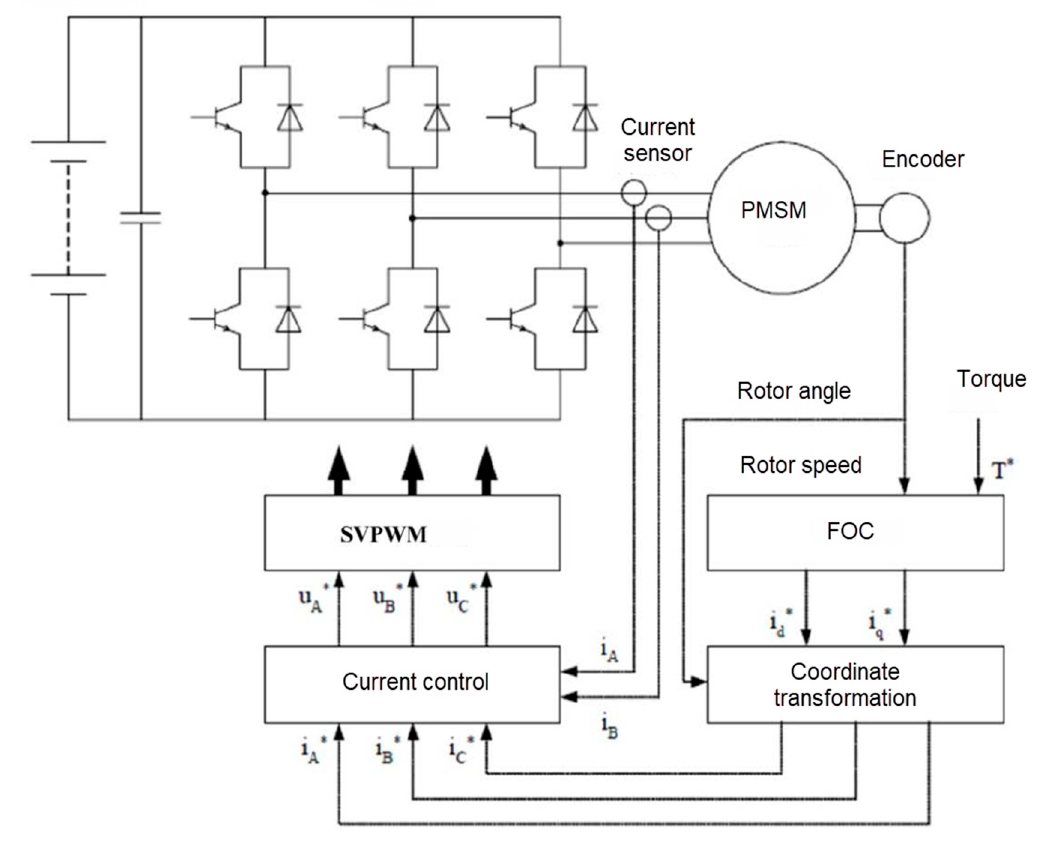
Figure 4. Vector control system of PMSM.